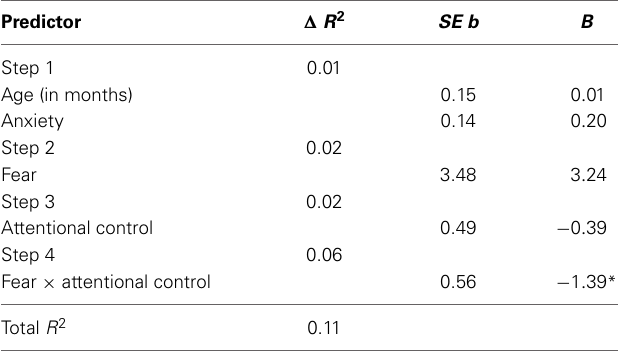
Table 3 | Summary of hierarchical regression analysis for variables predicting attentional biases toward angry faces.